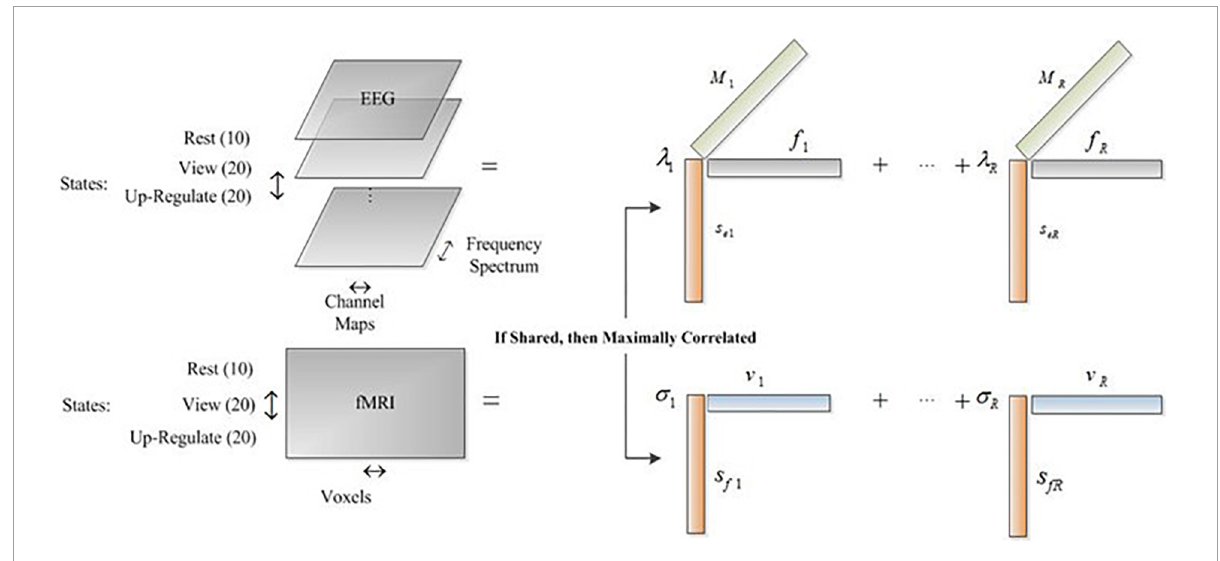
FIGURE1 The arrangement of datasets for CCMTF